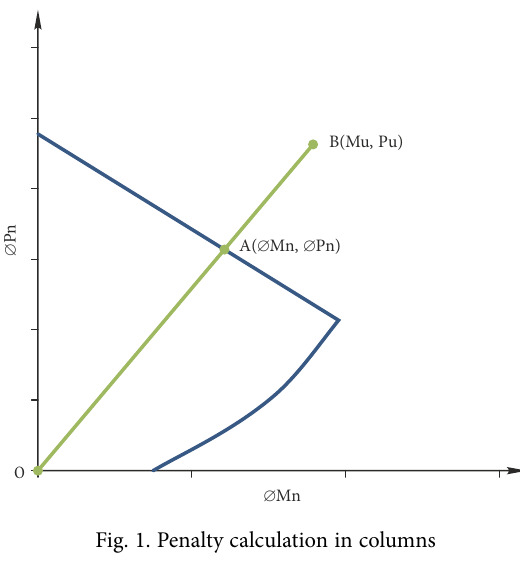
Fig. 1. Penalty calculation in